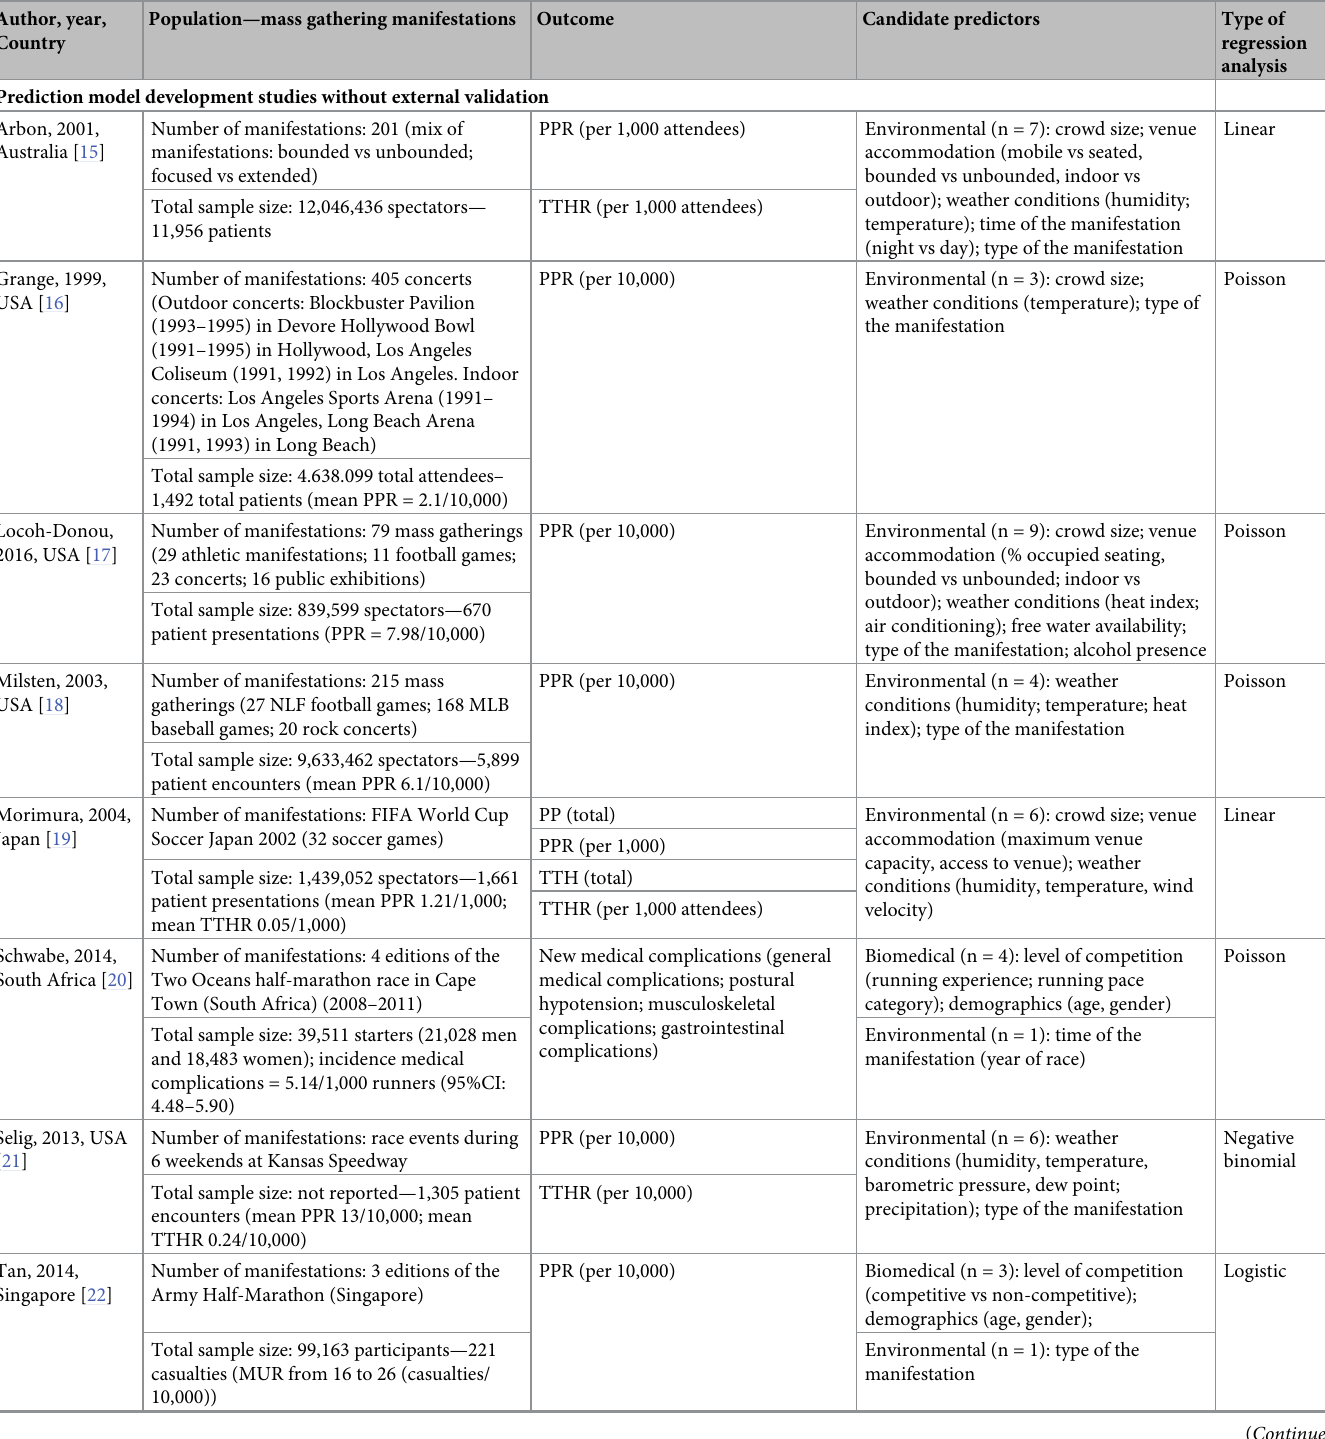
Table 1. Characteristics of included